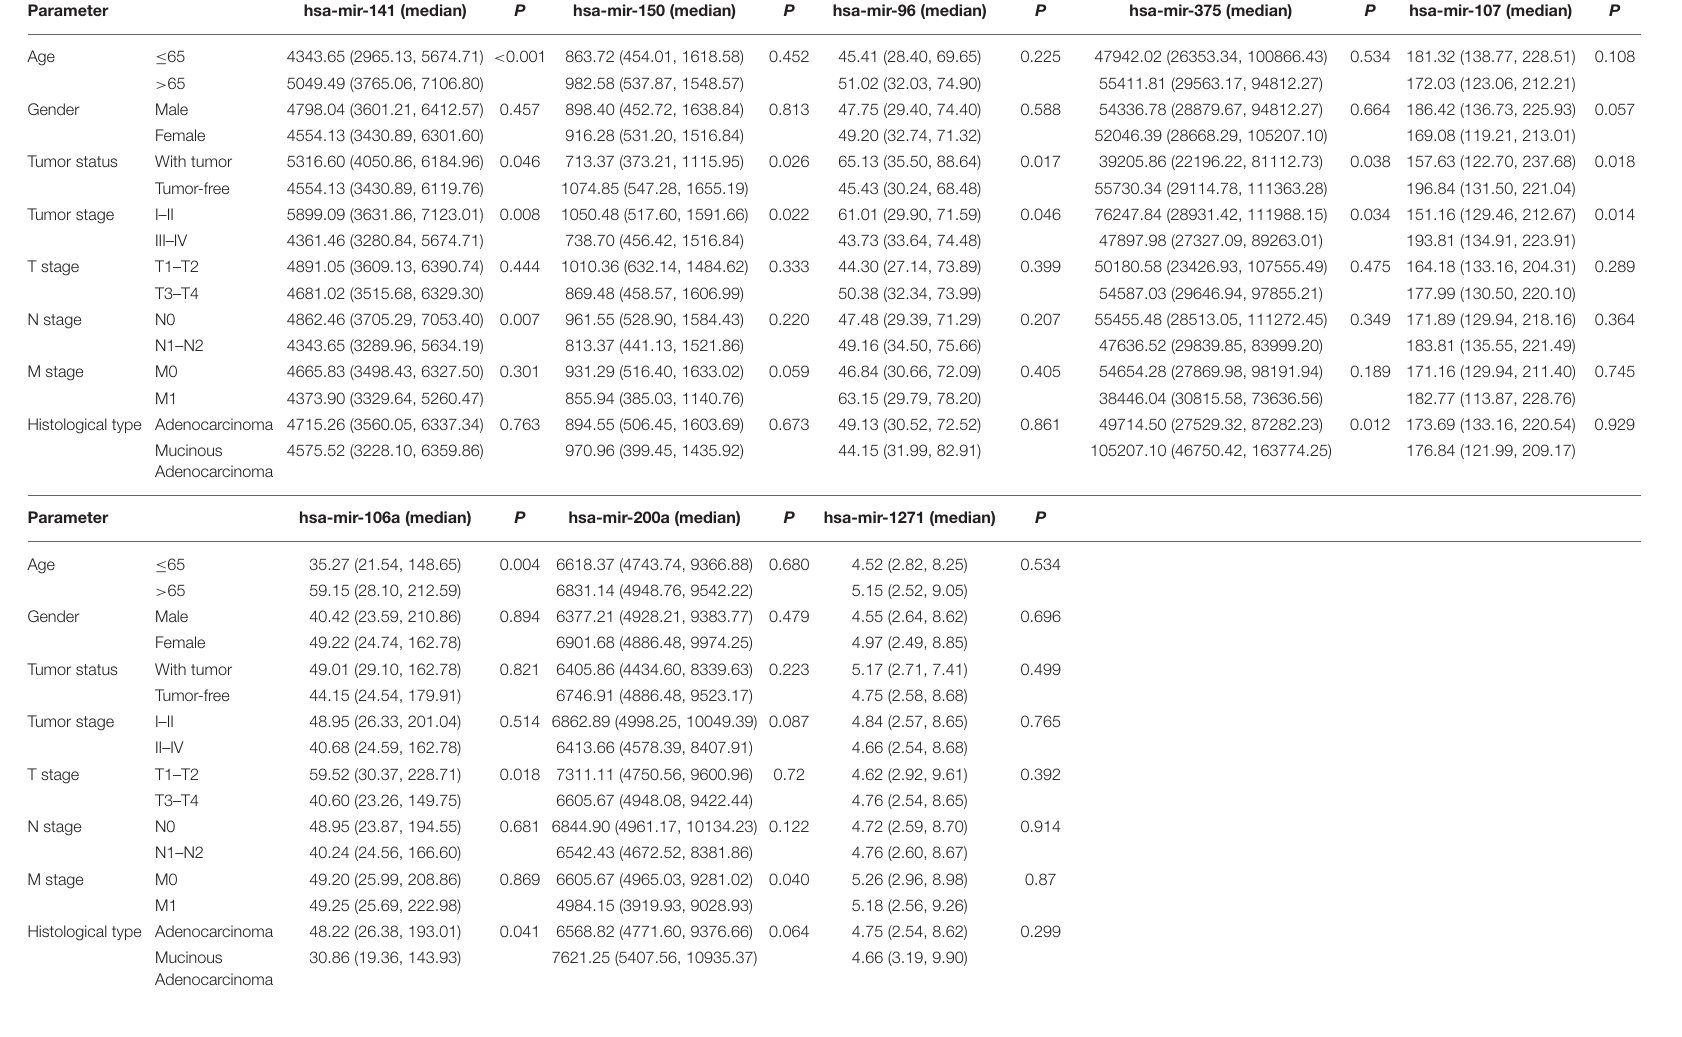
TABLE 2 | Relationships between the expression of eight miRNAs and clinical parameters in the